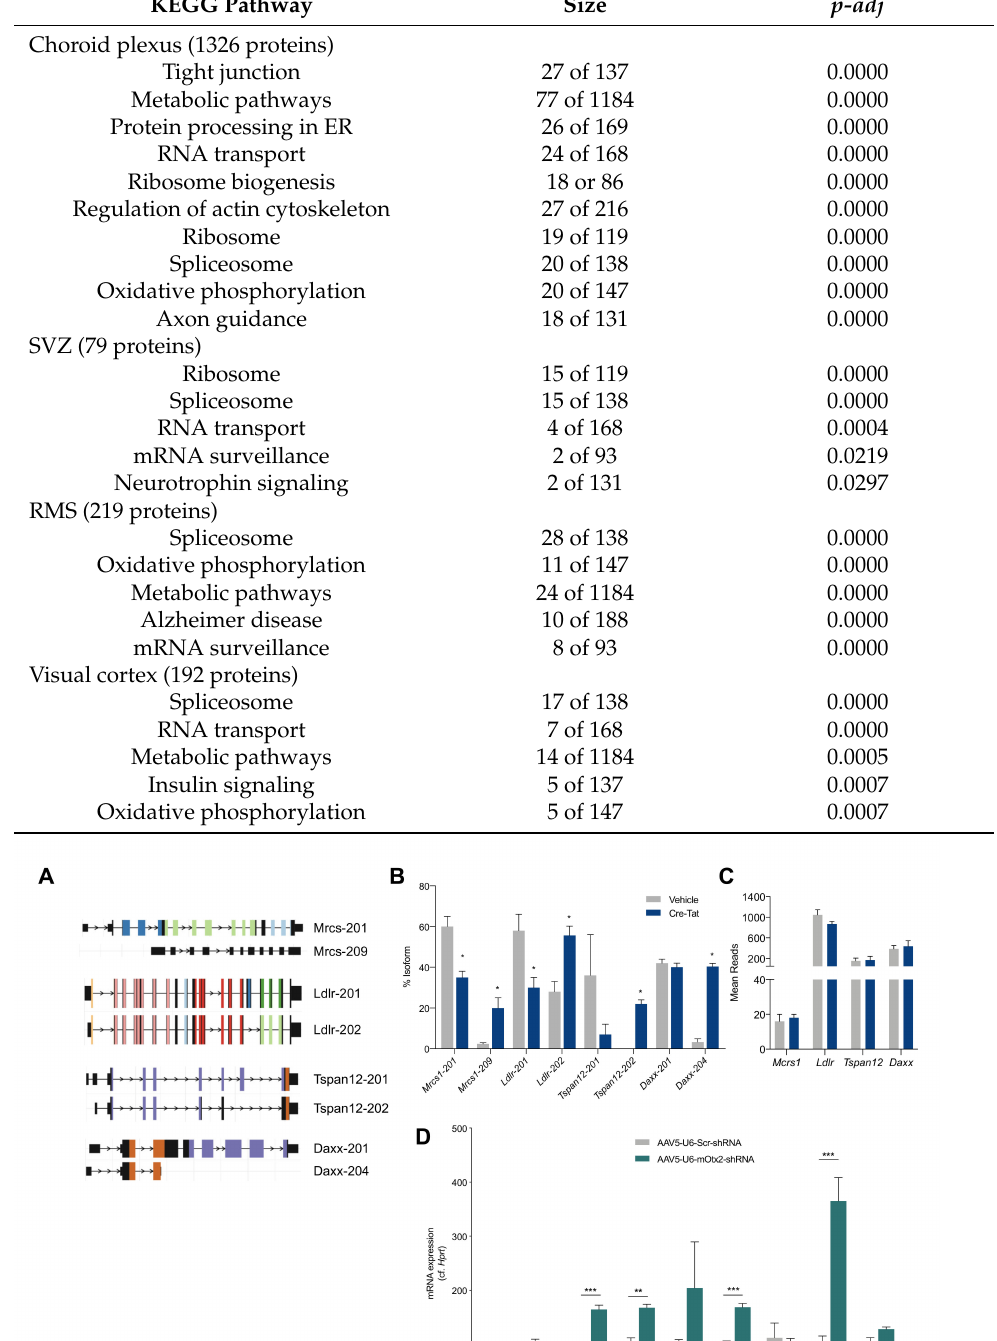
Table 8. List of KEGG pathways associated with putative cell- and non-cell-autonomous OTX2 protein partners.